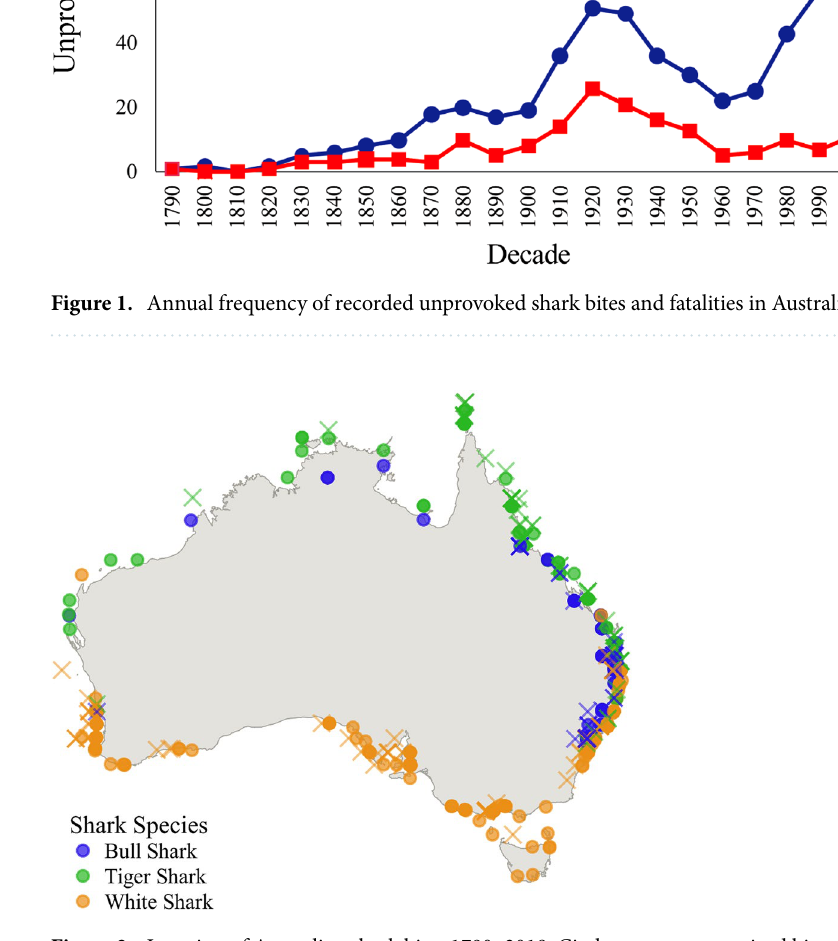
Figure 2. Location of Australian shark bites 1790–2018. Circles represent survived bites, X represents fatalities. Figure created using QGIS v. 3.16.2 (www. qgis.